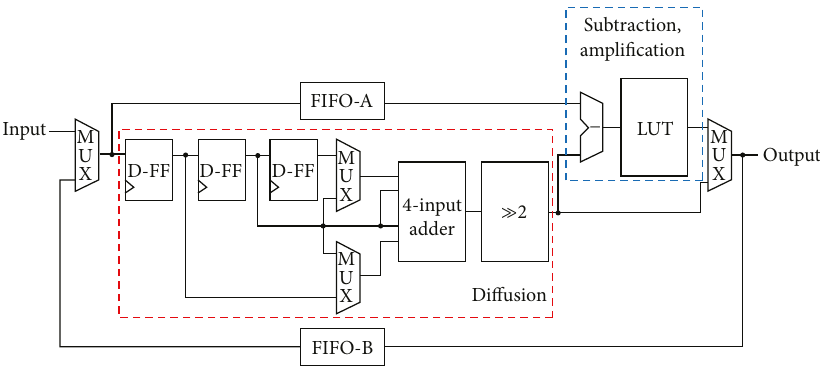
Figure 2: Protoarchitecture of the one-dimensional RD